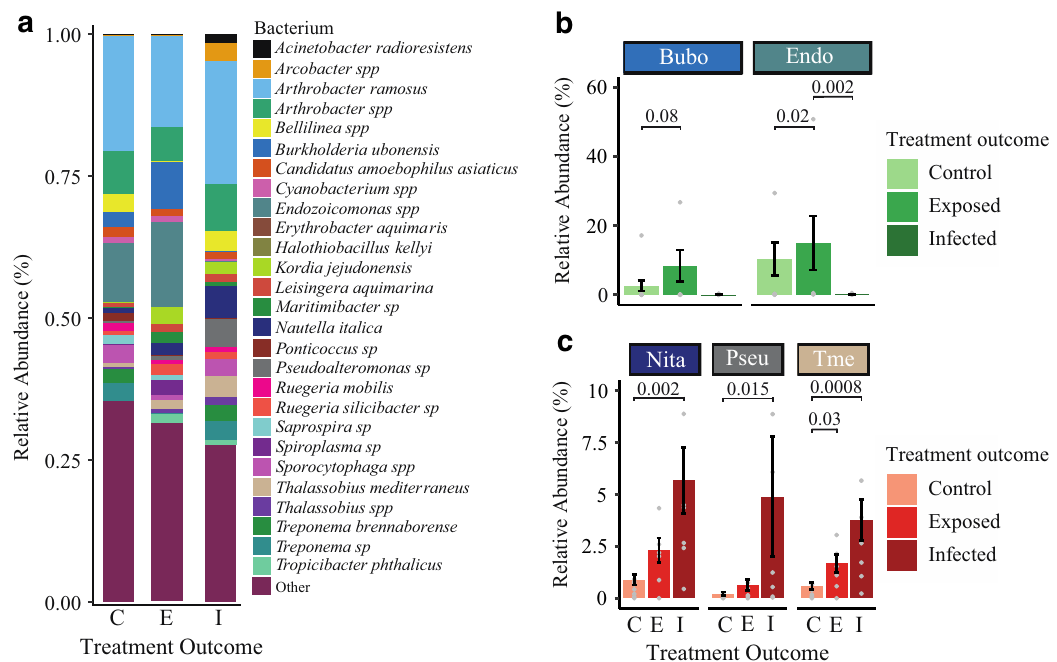
Fig. 6 Treatment outcome-speci fi c bacterial community. a Bacteria of 3% relative abundance or higher in any treatment outcome. b Two bacteria that increased in disease-exposed fragments, ( c ) Three bacteria that signi fi cantly increased in disease-infected fragments. Abbreviations correspond to the following bacterial species: “ Bubo ” = Burkholderia ubonensis , “ Endo ” = Endozoicomonas spp ., “ Nita ” = Nautella italica , “ Pseu ” = Pseudoalteromonas sp ., “ Tme ” = Thalassobius mediterraneus . Bar plot annotations are signi fi cant p -values from the Tukey Post-hoc test, and the Dunn test for Endozoicomonas spp ., omitted p -value annotations are none signi fi cant comparisons. Individual data points are represented by light gray dots and error bars represent standard